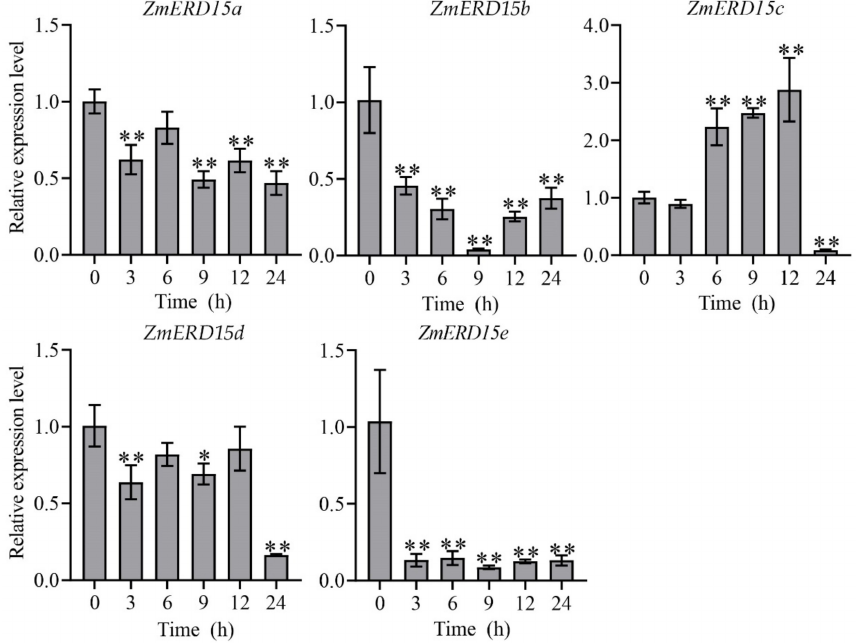
Figure 5. Expression of ZmERD15s in response to osmotic stress using 16% PEG-6000. * and ** indicate significant differences from the level of expression at time 0 at p < 0.05 and p < 0.01, respectively.